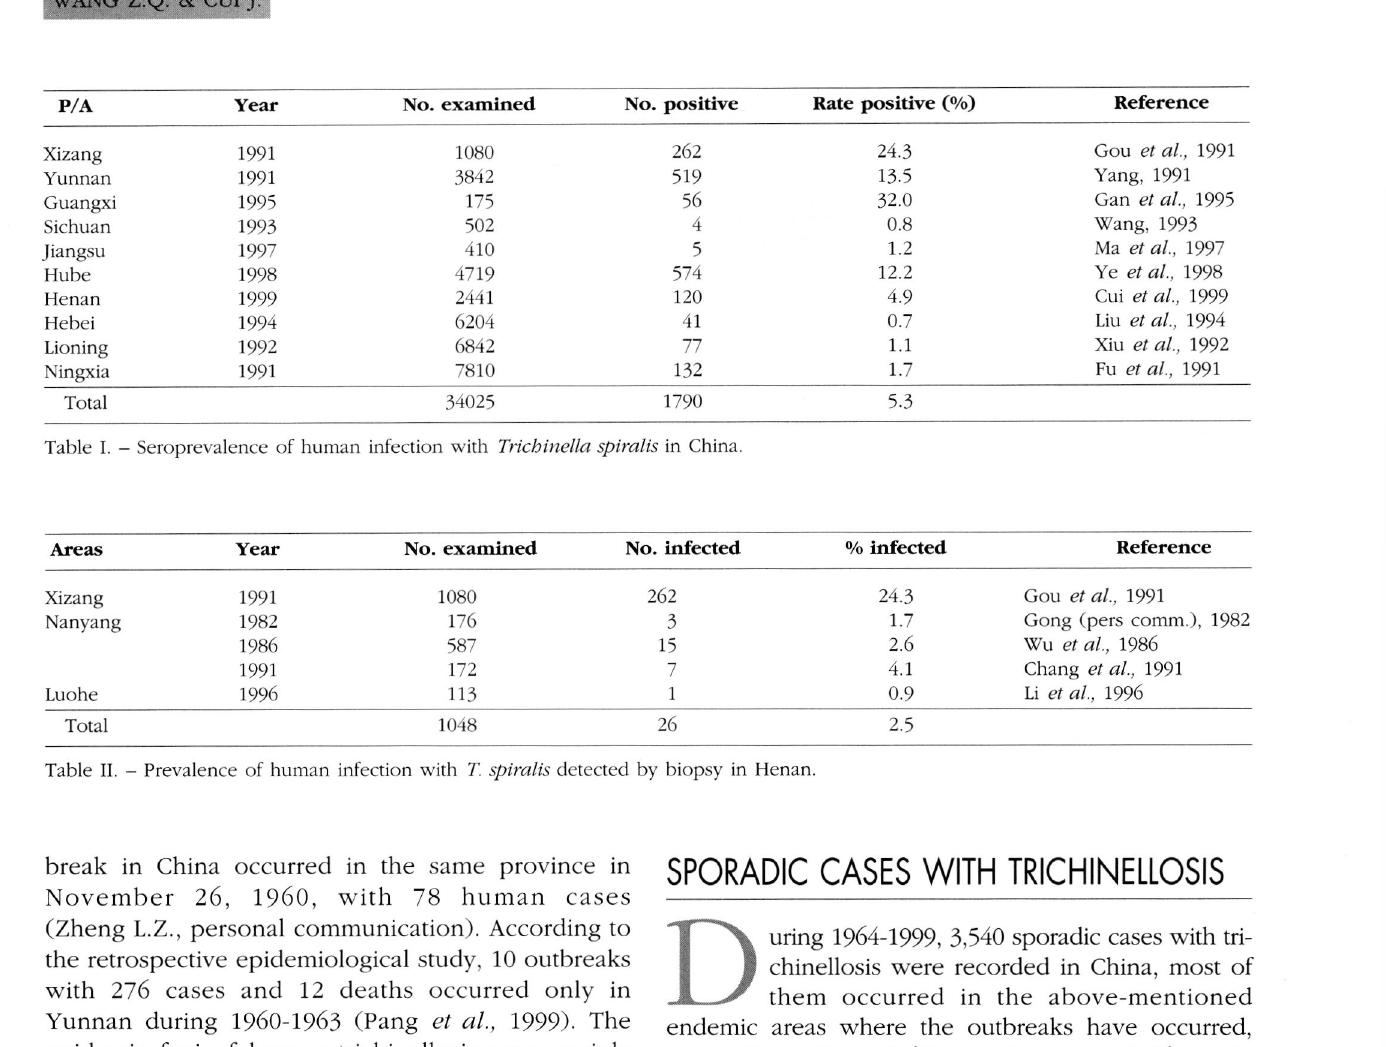
Table II. - Prevalence of human infection with T. spiralis detected by biopsy in Henan.